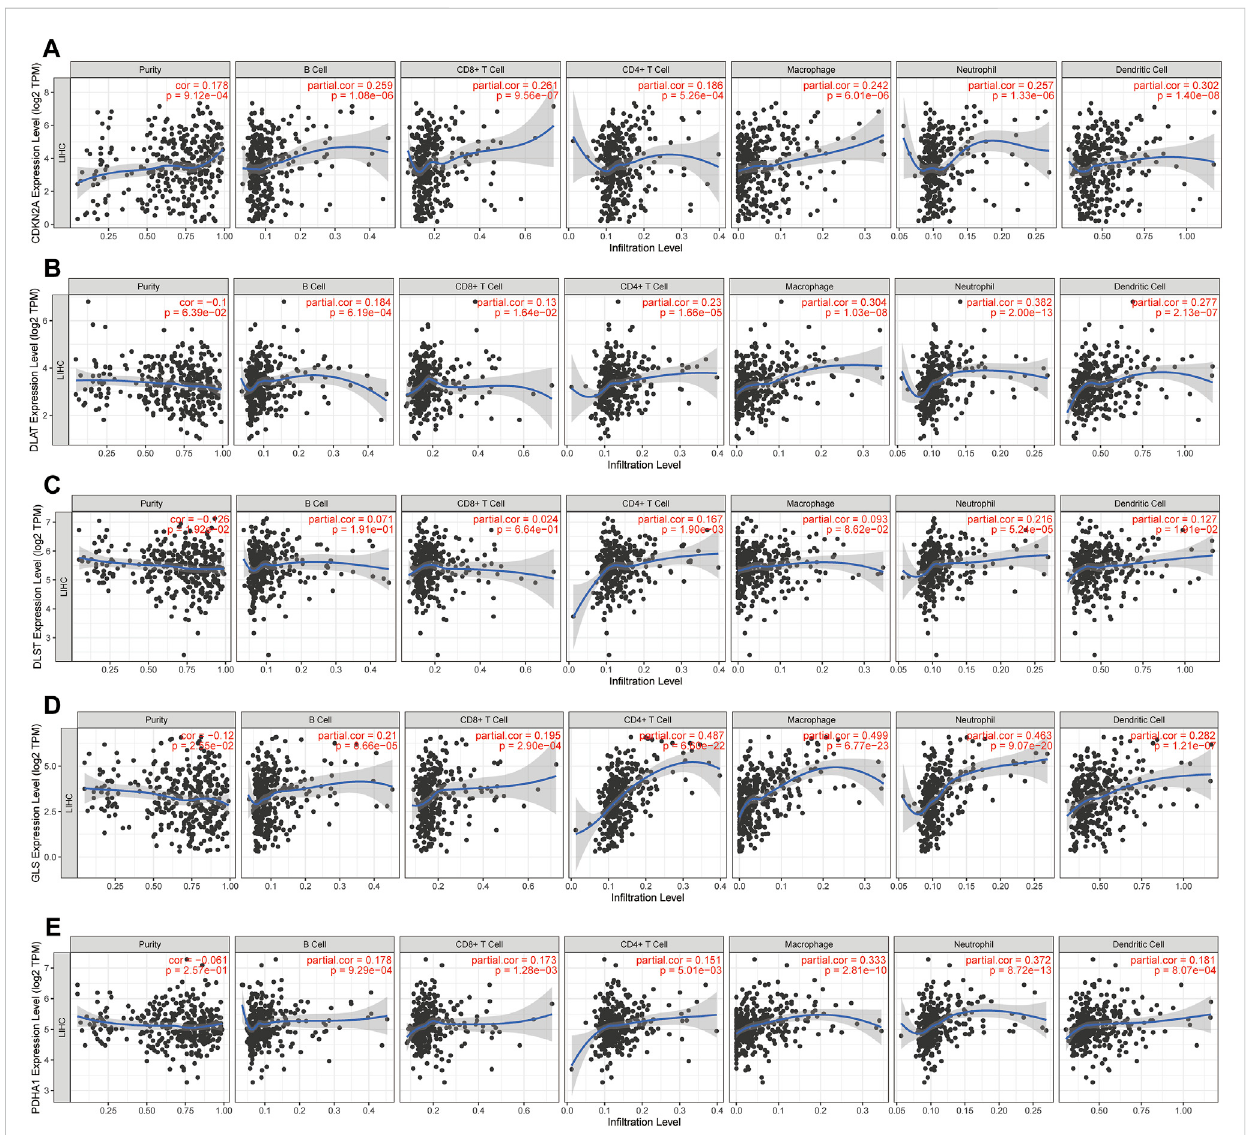
FIGURE 10 Prognostic CRGs involved in immune in fi ltration in HCC. (A-E) Association between immune cell abundance in HCC and prognostic CRGs (TIMER